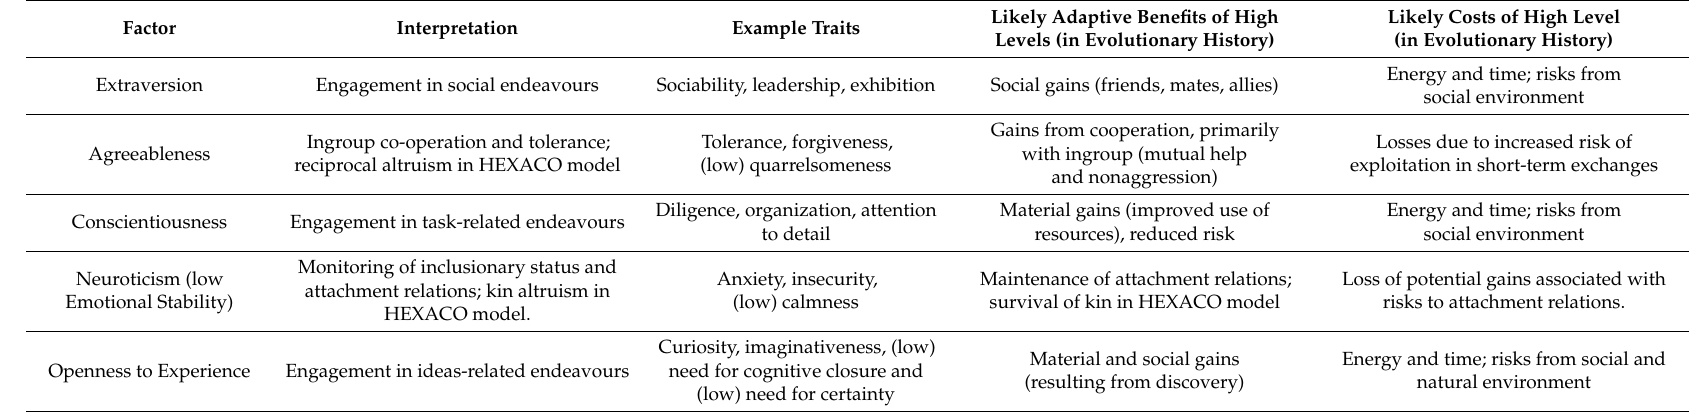
Table A1. Interpretation of Big-Five personality traits, including example traits, and likely adaptive benefit and costs resulting from high levels of each personality dimension (adapted from Sibley et al.)